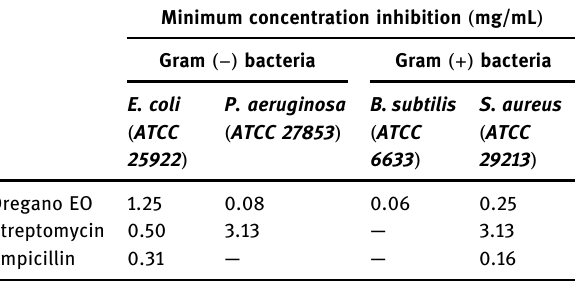
Minimum concentration inhibition ( mg/mL